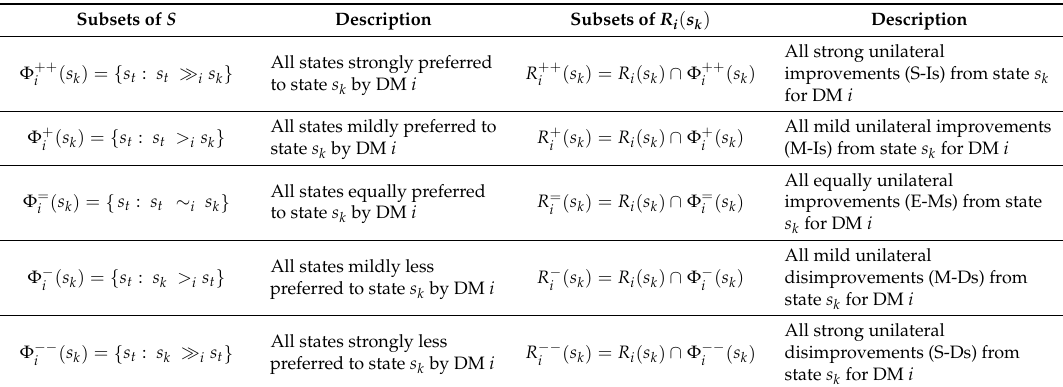
Table 1. Subsets of S and subsets of R i ( s k )